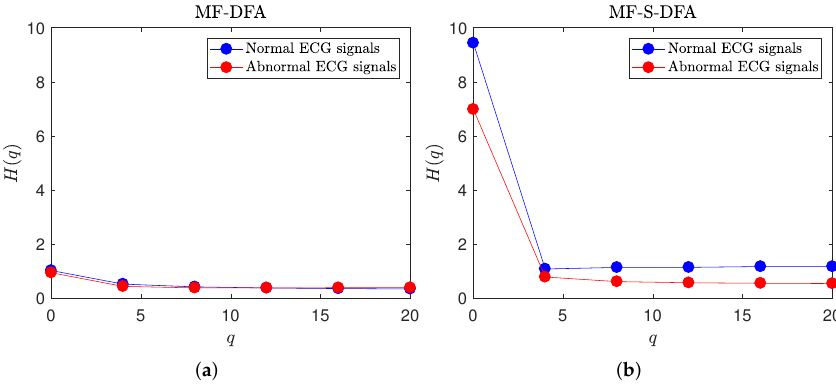
Figure 11. Generalized Hurst exponent H ( q ) extracted by ( a ) MF-DFA and ( b ) MF-S-DFA. A color version of the figure is available in the web version of the article.